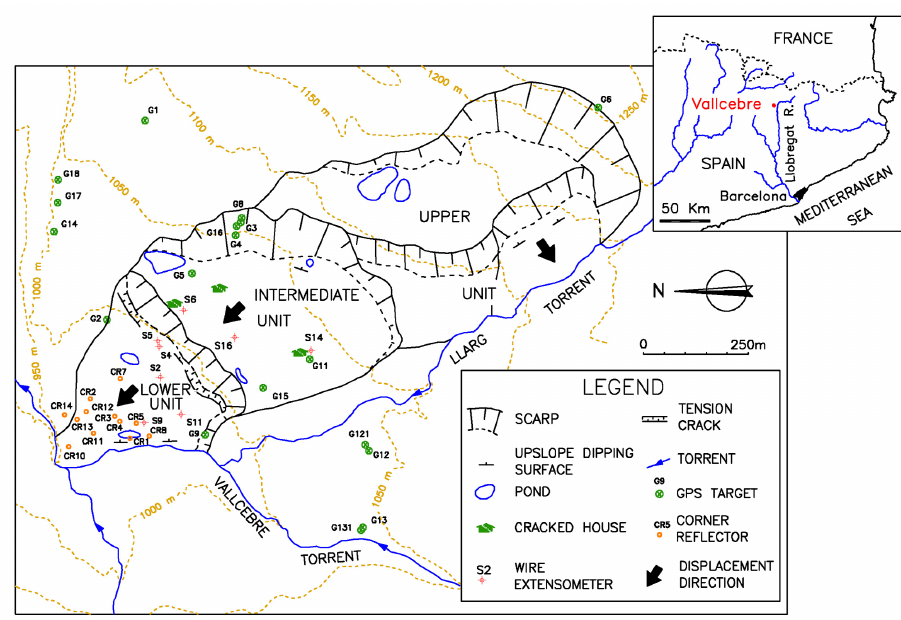
Fig. 3. Geomorphological sketch of the Vallcebre landslide (Corominas et al., 2005).